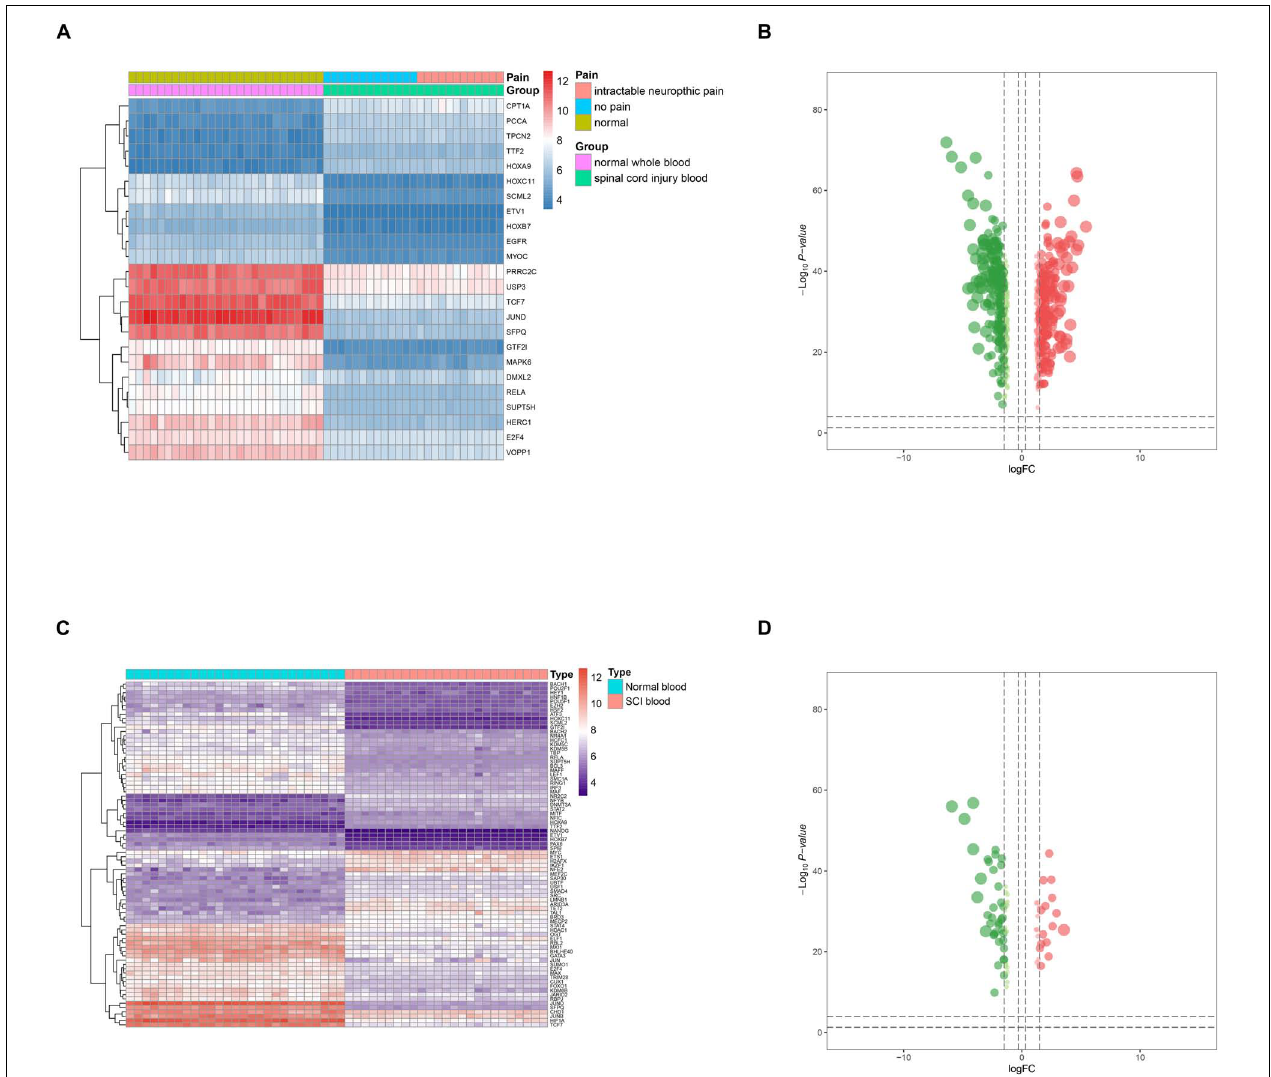
FIGURE 3 | Identification of differentially expressed spinal cord injury (SCI)-related enhancer RNAs (eRNAs) and transcription factors (TFs). (A) Heat map showing the expression level of differentially expressed SCI-related eRNAs. (B) Volcano plot showing the p -value and log| FC| value of differentially expressed SCI-related eRNAs. (C) Heat map showing the expression level of differentially expressed TFs. (D) Volcano plot showing the p -value and log| FC| value of differentially expressed